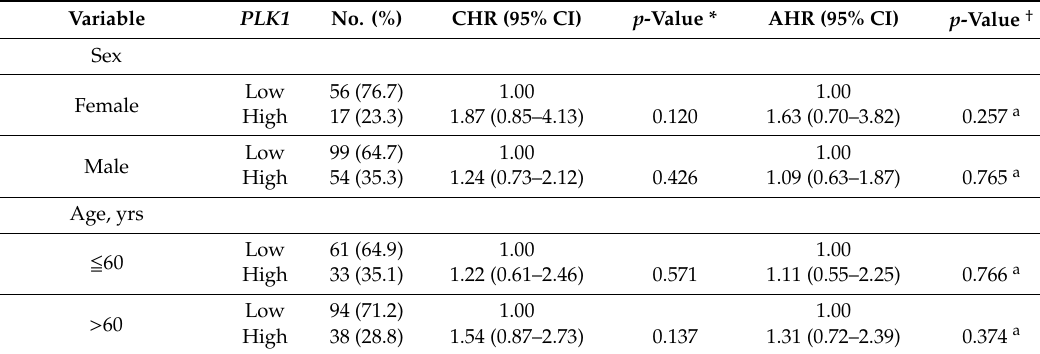
Table 3. Impact of PLK1 expression levels on disease-free survival by the di ff erent demographic and clinicopathologic factors with